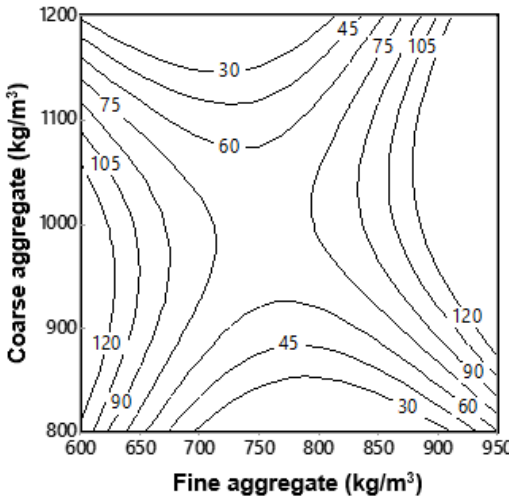
Figure 9. Isoresponse contours for compressive strength of SFRC.